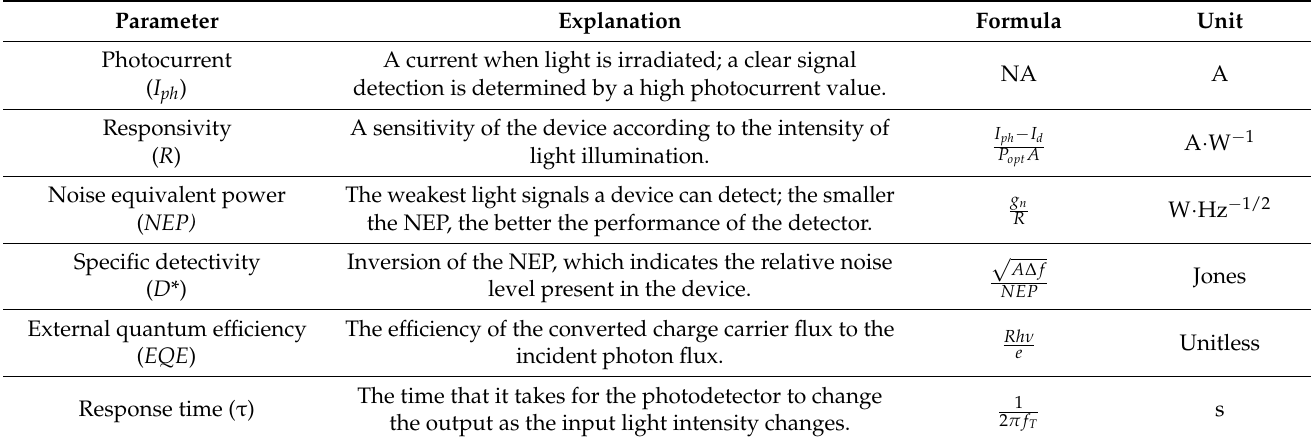
Table 1. Summary of several physical quantities in